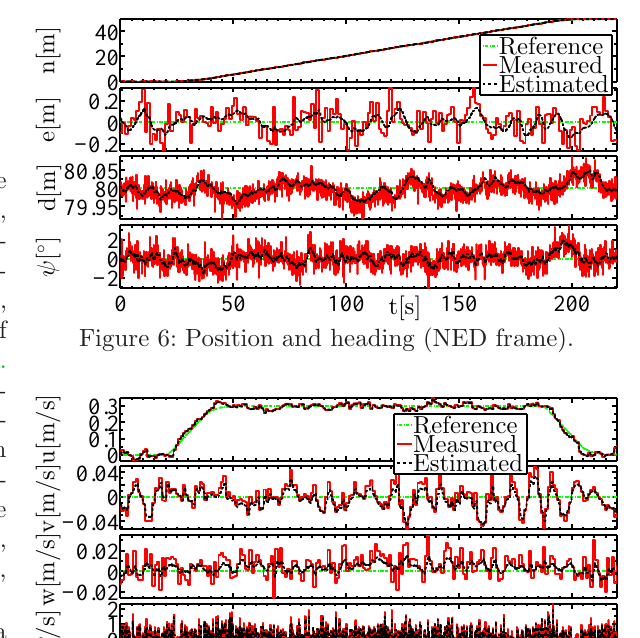
The maximum absolute heading error is < 4 ◦ . Figure 7 depicts the corresponding velocities along the path.